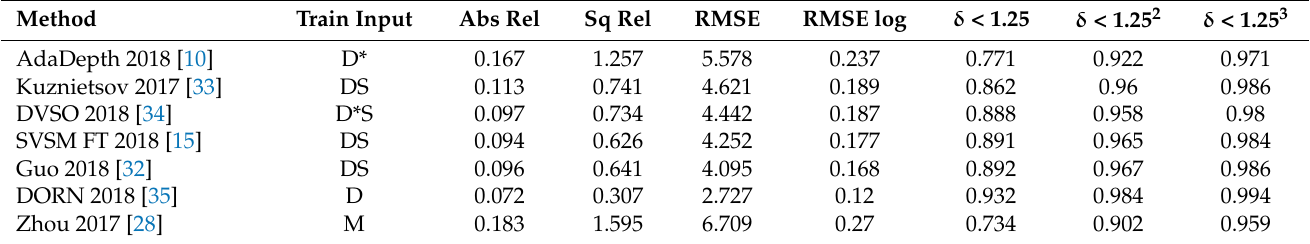
Table 2. Quantitative results with all variants of Monodepth2 [3] and other self-supervised methods on the KITTI 2015